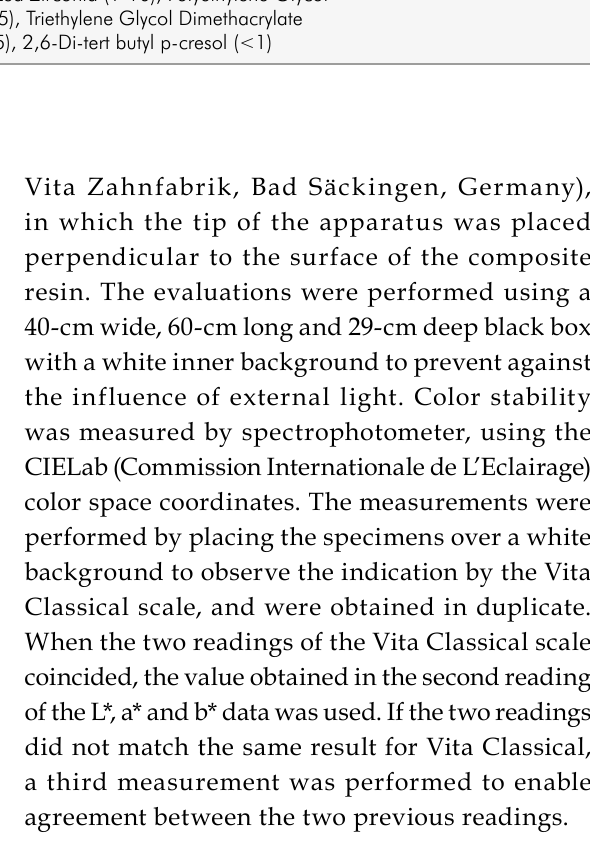
Table 1. Specification of materials under study. Trademark / Manufacturer (City, State, Country) / Lot